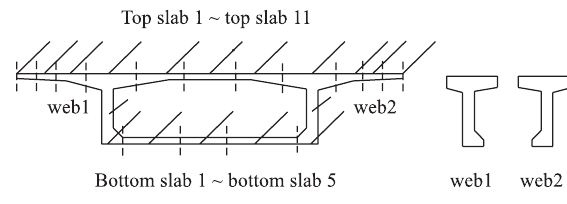
Fig. 11. The division of cross-section of box girder